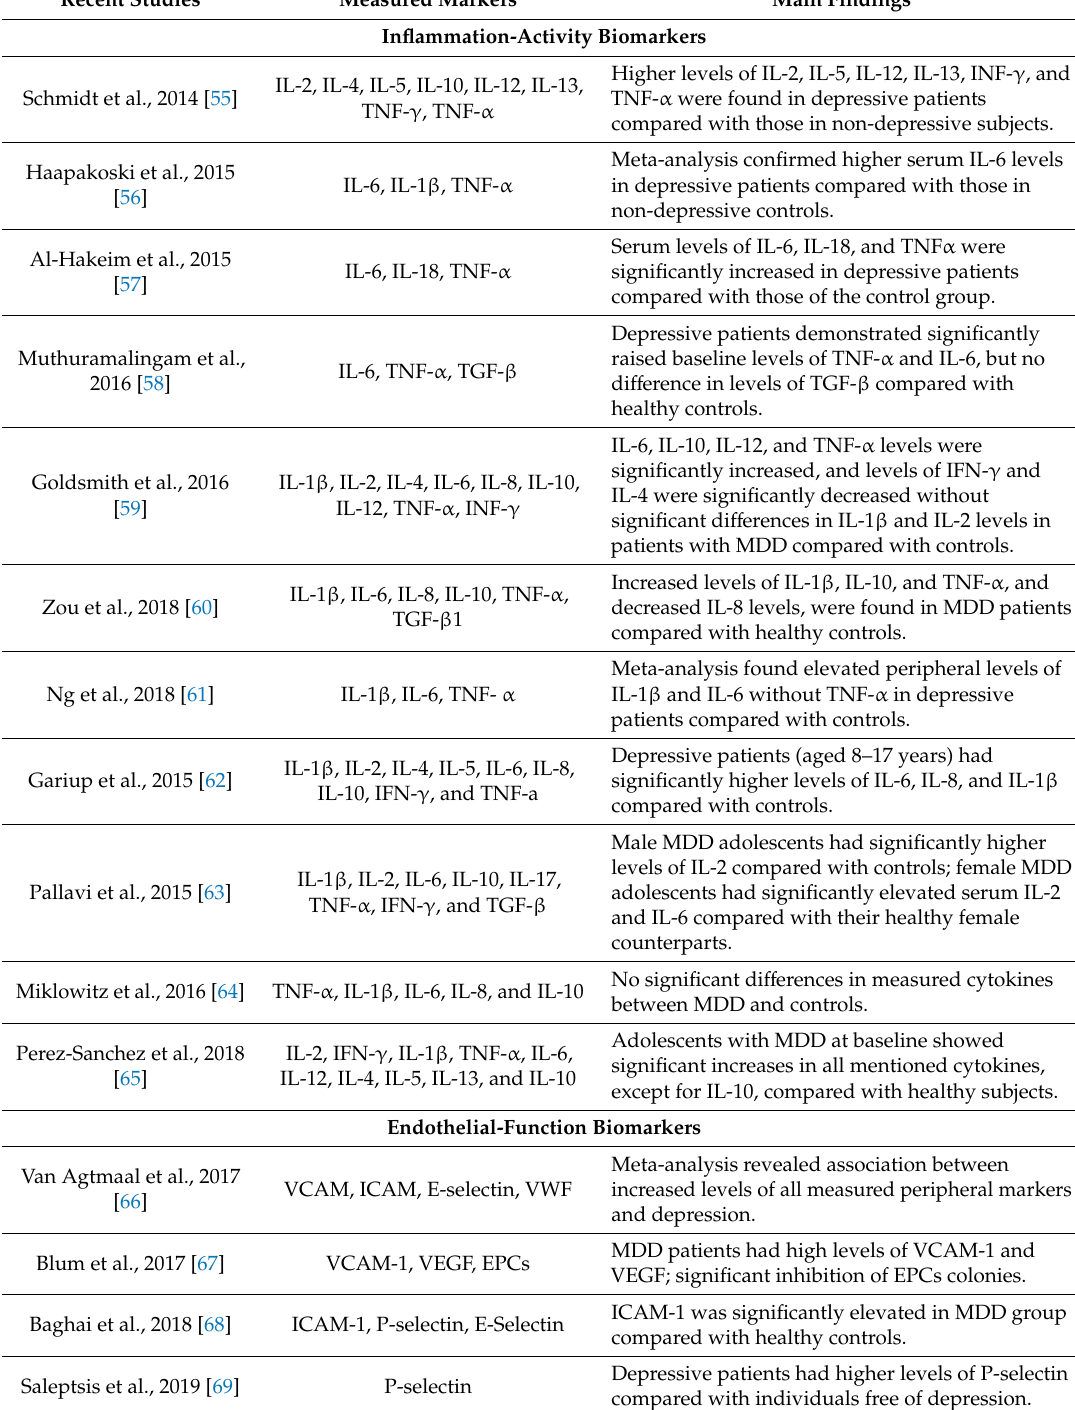
Table 1. Recent preview of peripheral biomarkers of inflammation activity and endothelial function in